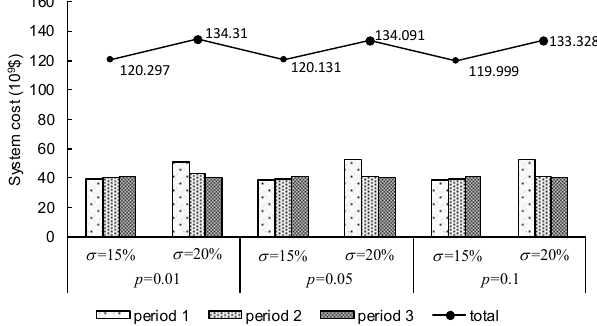
Figure 5. Economic cost under different p levels and σ values.